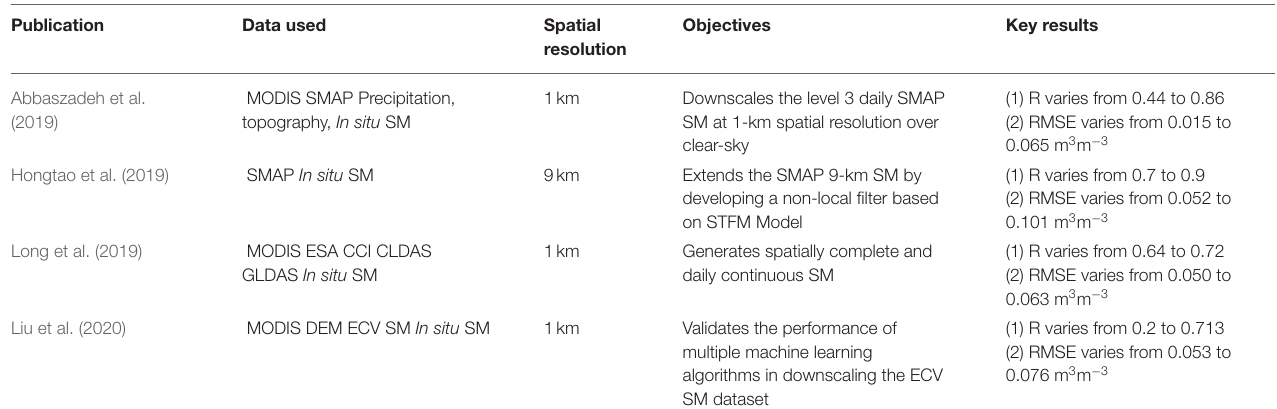
TABLE 5 | Summary of relevant studies to obtain daily SM data using multi-source remote sensing